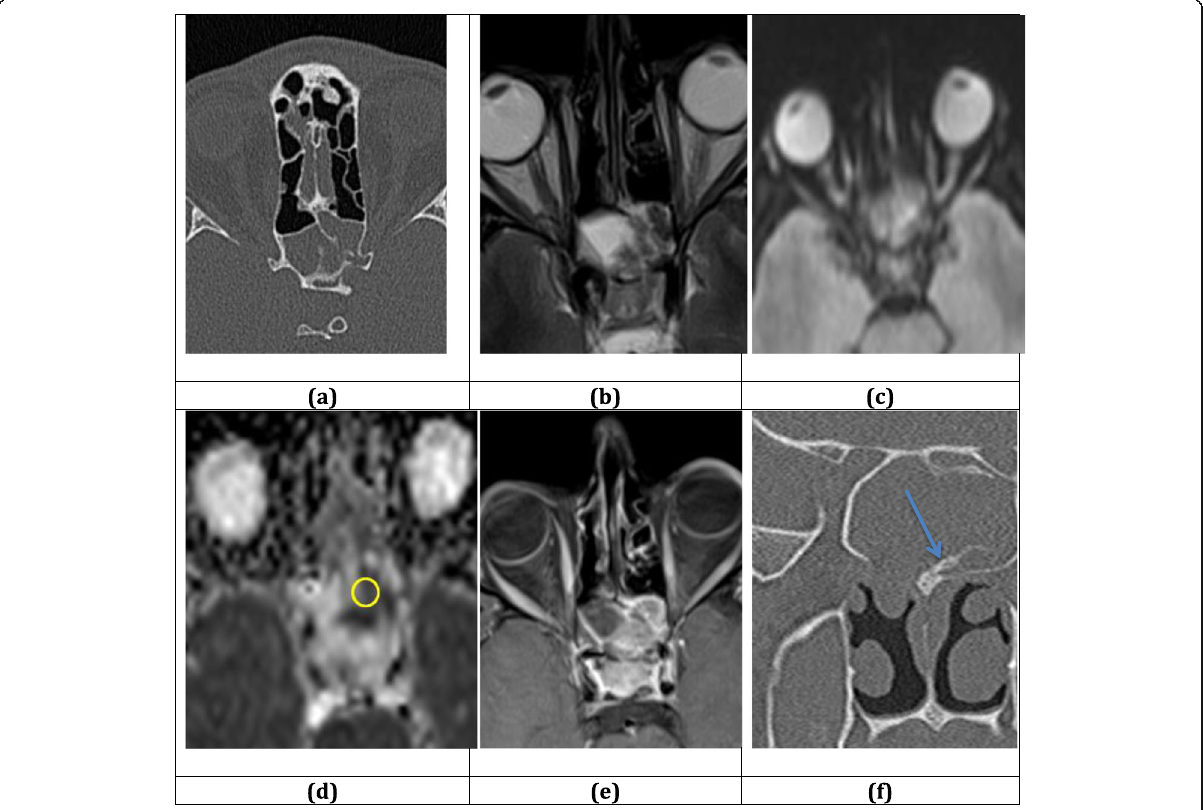
Fig. 6 A 35-year-old man with operated sphenoid sinus inverted papilloma. Axial post-operative computed tomography ( a ) reveals thick sclerotic septa that could be post-operative neo-osteogenesis rather than neoplastic induced. Axial T2-weighted reveals ( b ) the solid recurrent lesion as frond-like tissue on left side of the sphenoid cavity, with linear striations. Axial diffusion in ( c ) shows low spatial resolution reflected by too much bone-air interfaces, still apparent diffusion co-efficient map ( d ) nicely shows restricted tissue of only 0.9 × 10 -3 cm 2 /s. Post-gadolinium image ( e ) shows enhanced solid component with too much less visibility of striations. Coronal computed tomography ( f ) reveals extension through the posterior nasal recess and endoscopic defect. Focal linear sclerosis of intra-sinus septum is seen (blue arrow) which may suggest surgery